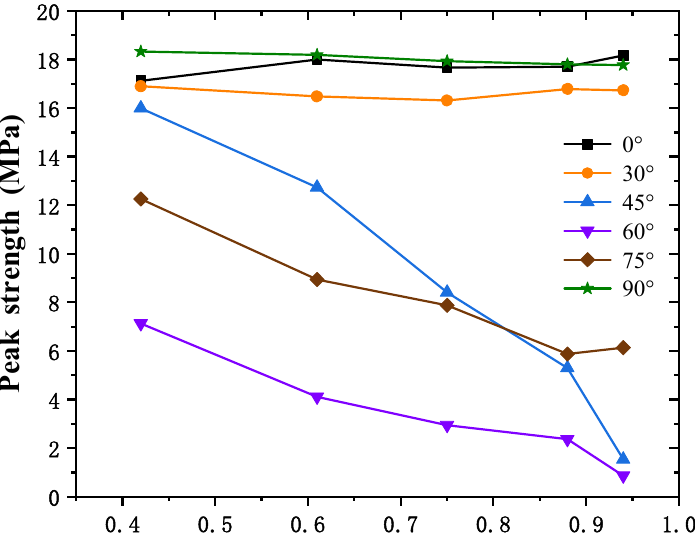
Figure 4. Variation in peak strength with joint persistence.